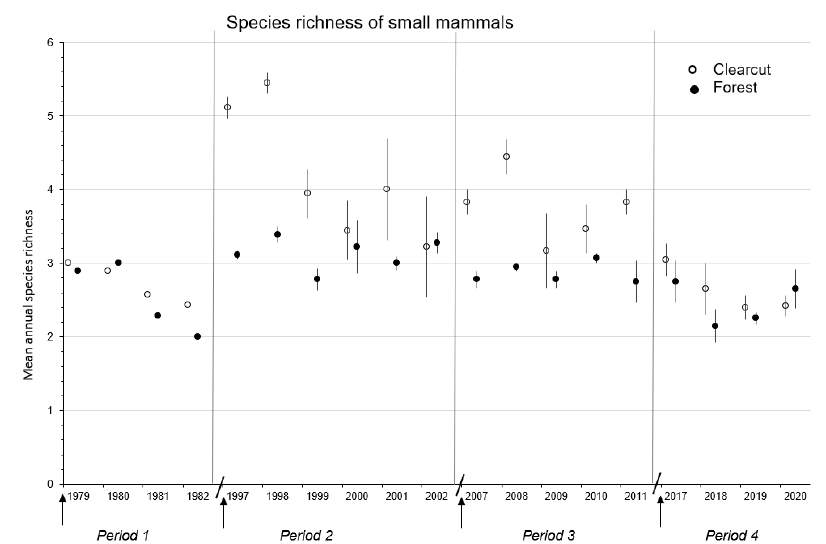
Figure 2. Mean ( n = 1, 3, or 4 replicate sites) ± SE annual species richness of forest-floor small mammals in the first four to six complete years in clearcut and uncut forest sites during the Periods 1979–1982, 1997–2002, 2007–2011, and 2017–2020 for the CC-FOR study in southern British Columbia, Canada. Arrow indicates time of harvesting on clearcut sites. Diagonal line separates Periods . Mean annual species diversity of the small mammal communities was significantly ( F 3,7 = 10.18; p < 0.01) different across Periods 1 to 4 of cumulative forest harvesting with diversity being highest (DMRT; p = 0.05) overall in Periods 2 and 3 (Table 2 and Figure 3). Overall mean diversity was 1.7 to 2.4 times higher in Periods 2 and 3 than in 1 and 4 . Again, a significant ( p < 0.01) time effect reflected the general decline in diversity with post-har- vest year. Figure 3. Mean ( n = 1, 3, or 4 replicate sites) ± SE annual species diversity of forest-floor small mam- mals in the first four to six complete years in clearcut and uncut forest sites during the Periods 1979 – 1982, 1997 – 2002, 2007 – 2011, and 2017 – 2020 for the CC-FOR study in southern British Columbia, Canada. Arrow indicates time of harvesting on clearcut sites. Diagonal line separates Periods .